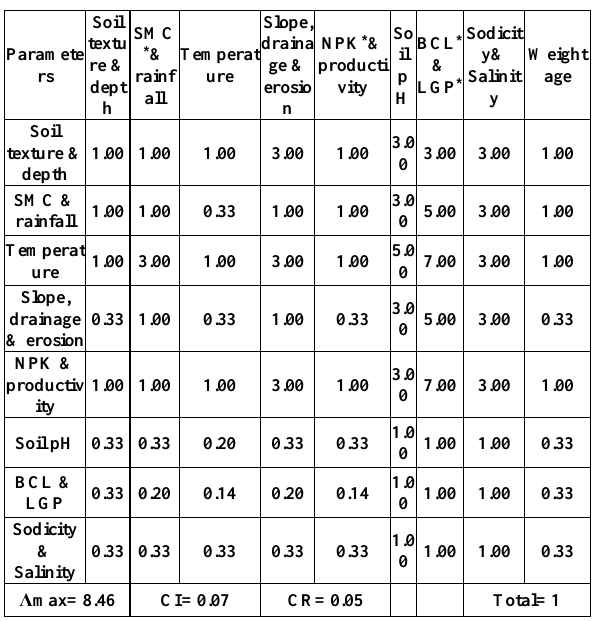
Table 10. Pairwise comparison matrix of selected criteria’s and their weights for Pearl millet *SMC- soil moisture content, NPK- nitrogen-phosphate-potash, BCL- bio climatic region, LGP- length of growing period.